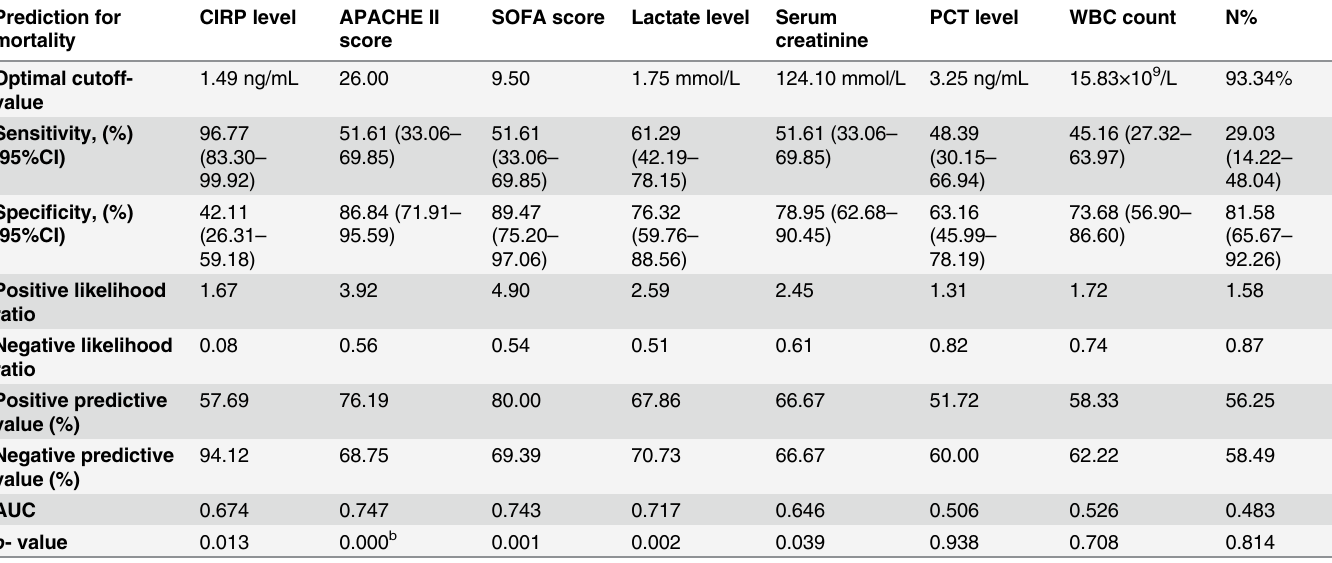
Table 3. Mortality prediction based on the plasma levels of the biomarkers and on the severity scores according to ROC curve analysis.